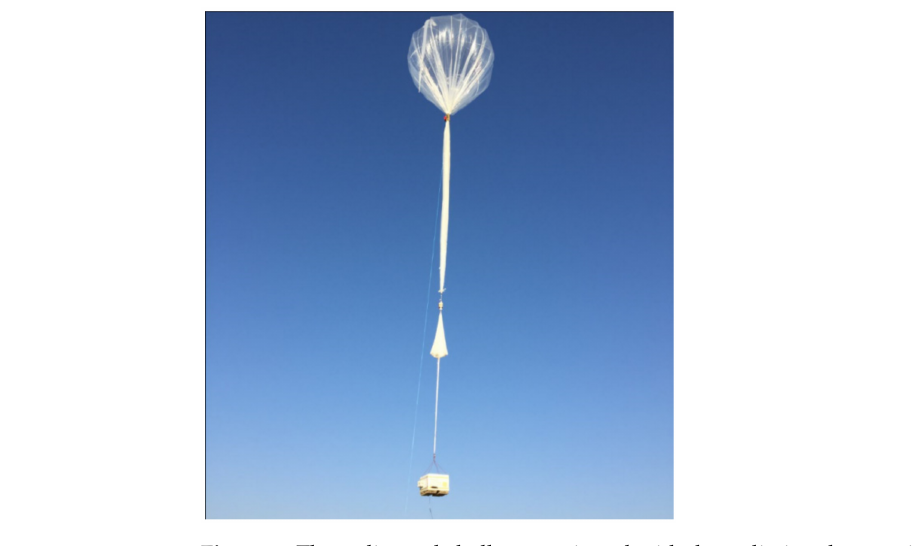
Figure 1. The radiosonde balloon equipped with the radiation detector in this study.